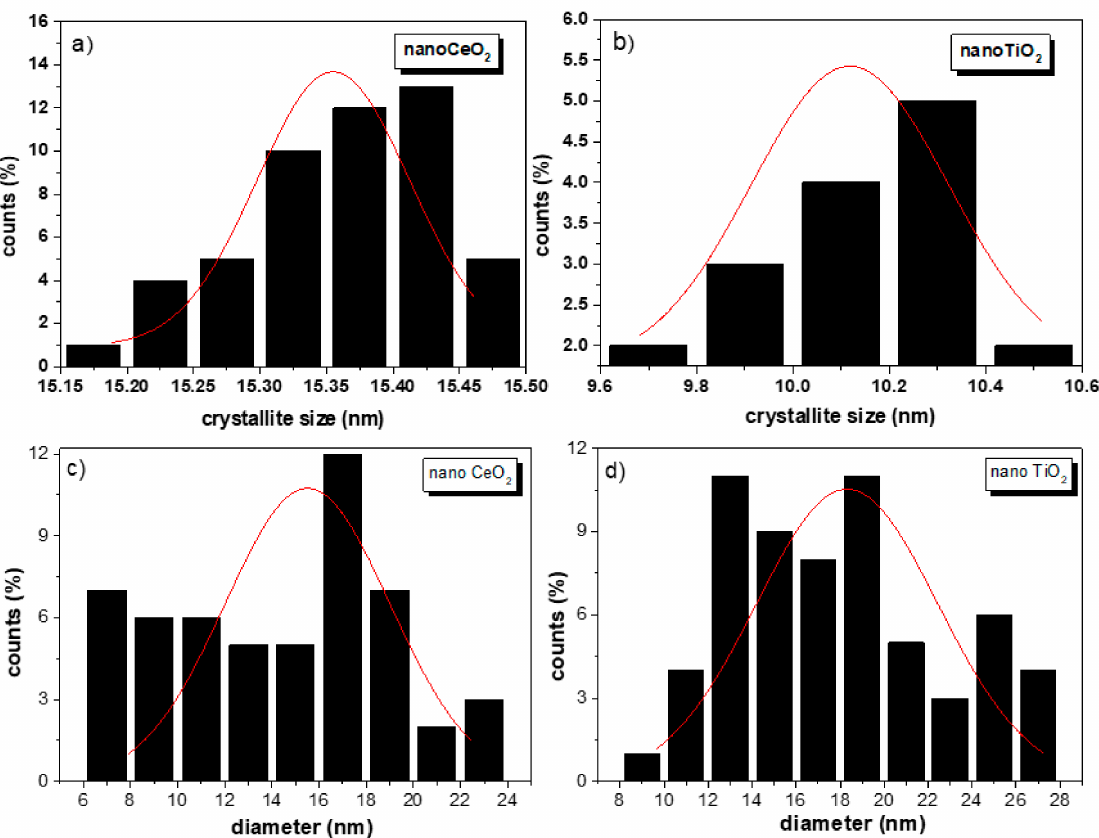
Figure 8. Domain size distribution and particle size distribution (PSD) histogram for nanoCeO 2 ( a , c ) and nanoTiO 2 ( b , d ).